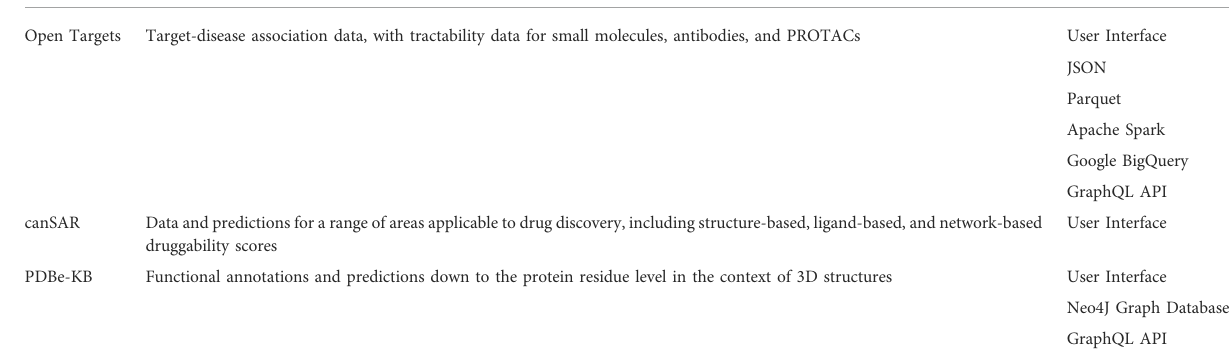
TABLE 1 Overview of data resources useful in the assessment of